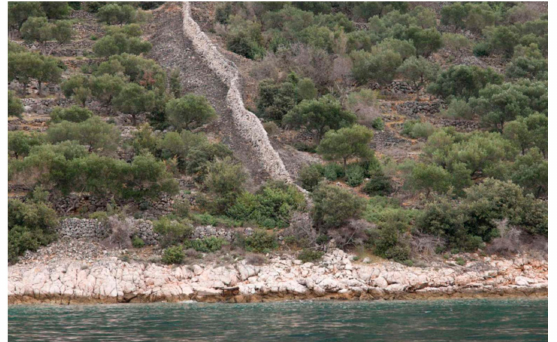
Figure 27. Pe´cnica is a dry stone wall structure, similar to dry stone wall shelters, which is used for drying figs in case they have been affected by summer rain (Loredana Velˇci´c, 2020).